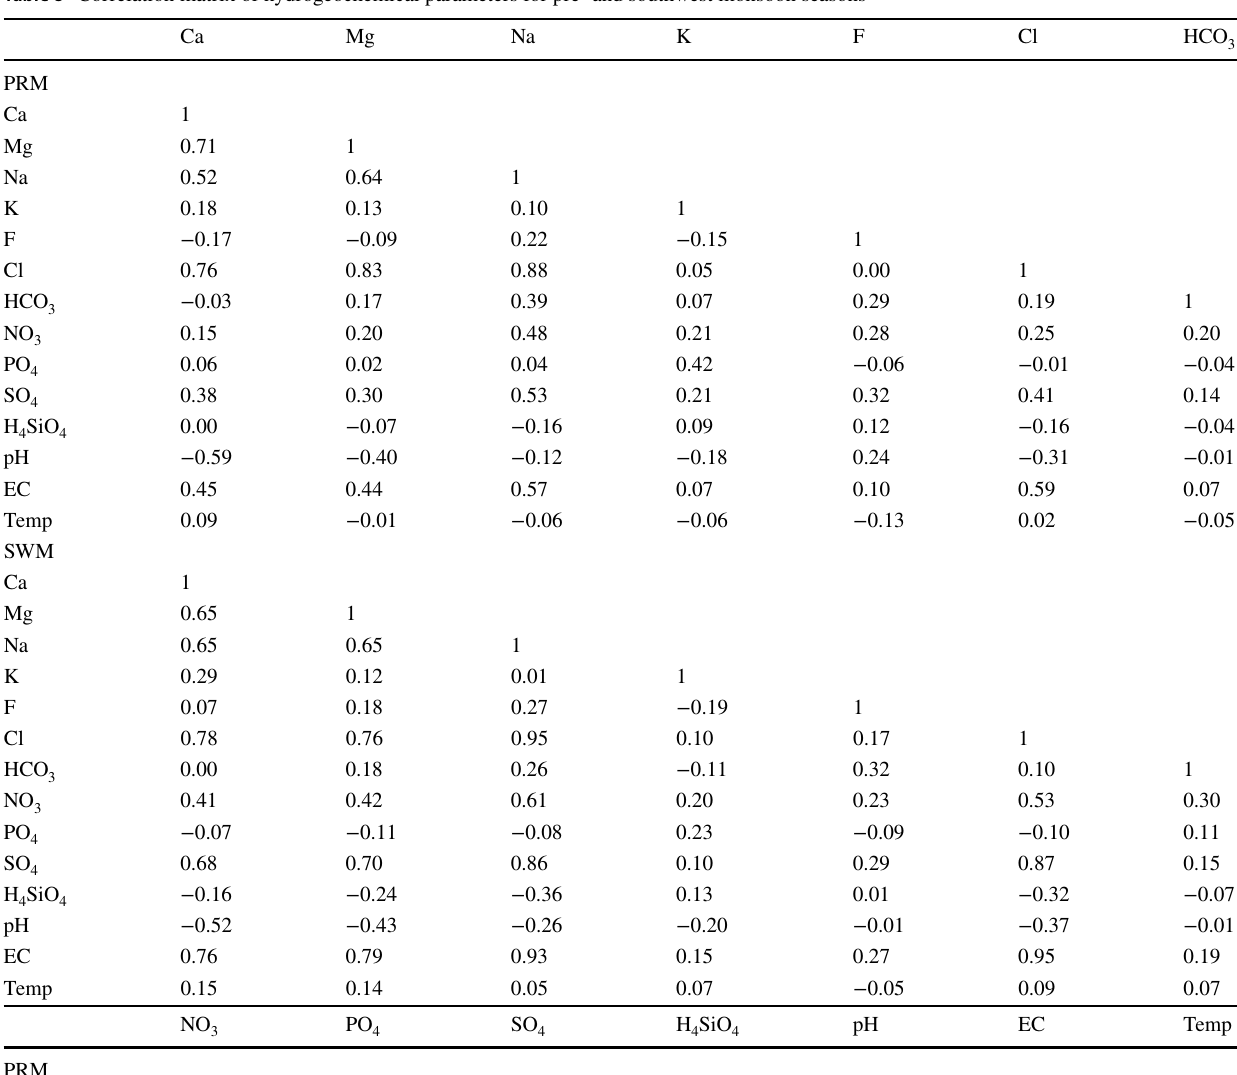
Table 8 Correlation matrix of hydrogeochemical parameters for pre- and southwest monsoon seasons Ca Mg Na K